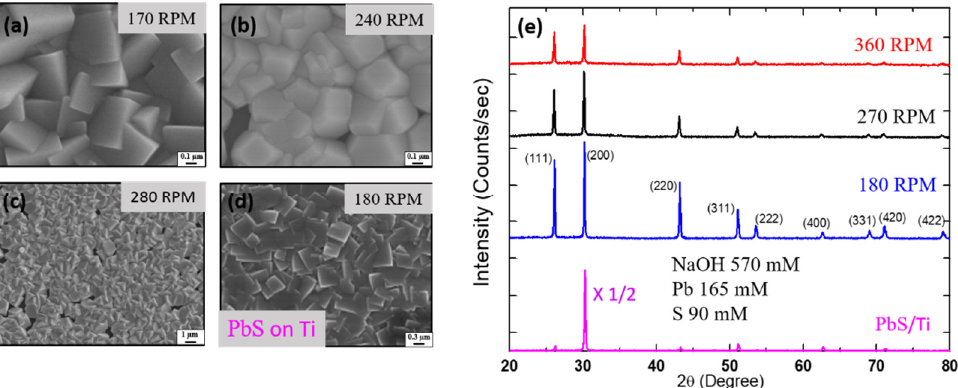
Figure 2. Surface SEM images of PbS films deposited on glass ( a – c ) and on Ti ( d ) using NaOH 570 mM, Pb 165 mM, S 90 mM. The values of stirring RPM are indicated. The density of the pinholes was increased as RPM was increased. ( e ) X-ray patterns of PbS deposited on Ti with 180 RPM and on glass with varying RPM values.